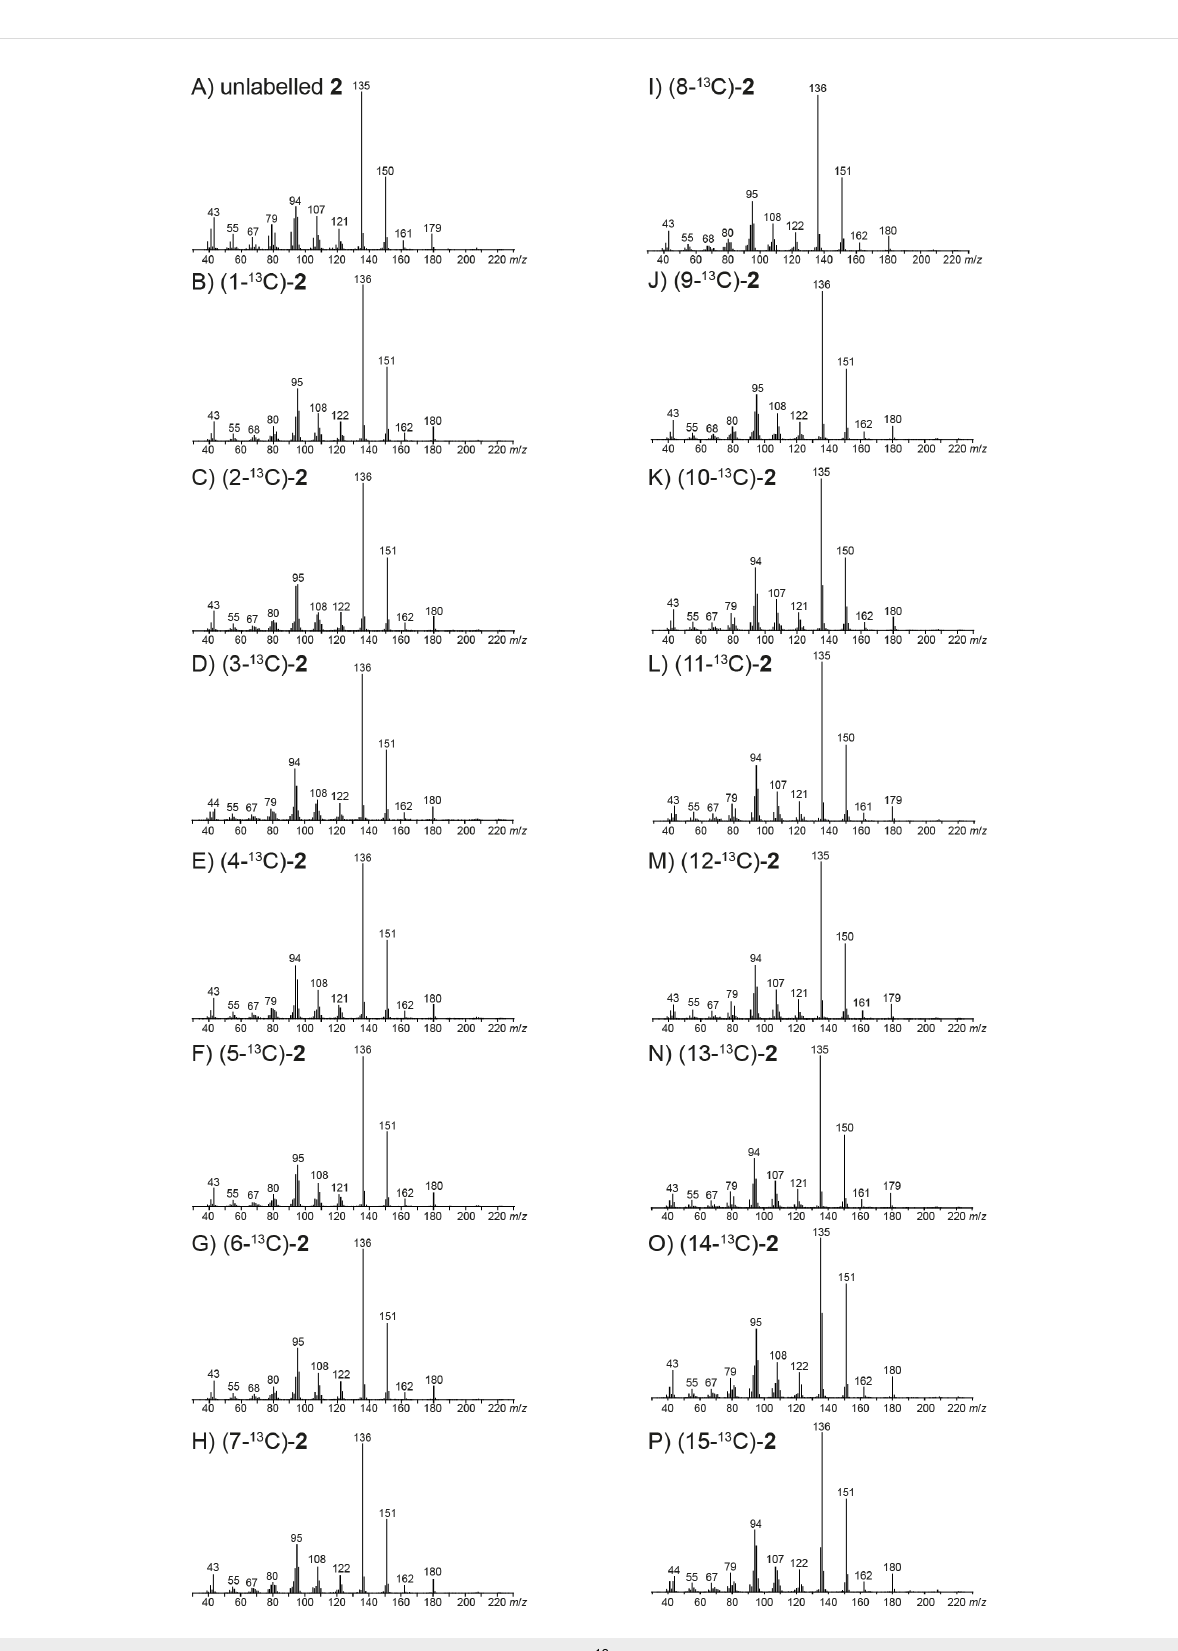
Figure 2: Mass spectra of unlabelled 2 and all fifteen positional isomers of ( 13 C 1 )- 2